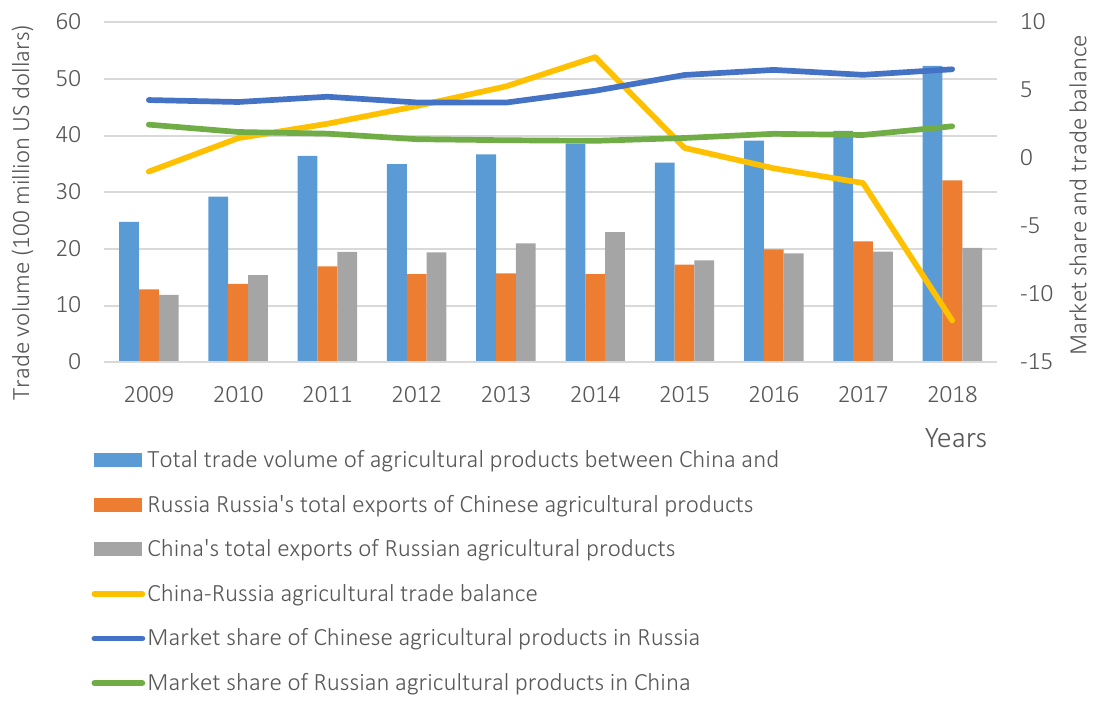
Figure 1. Agricultural trade between China and Russia,